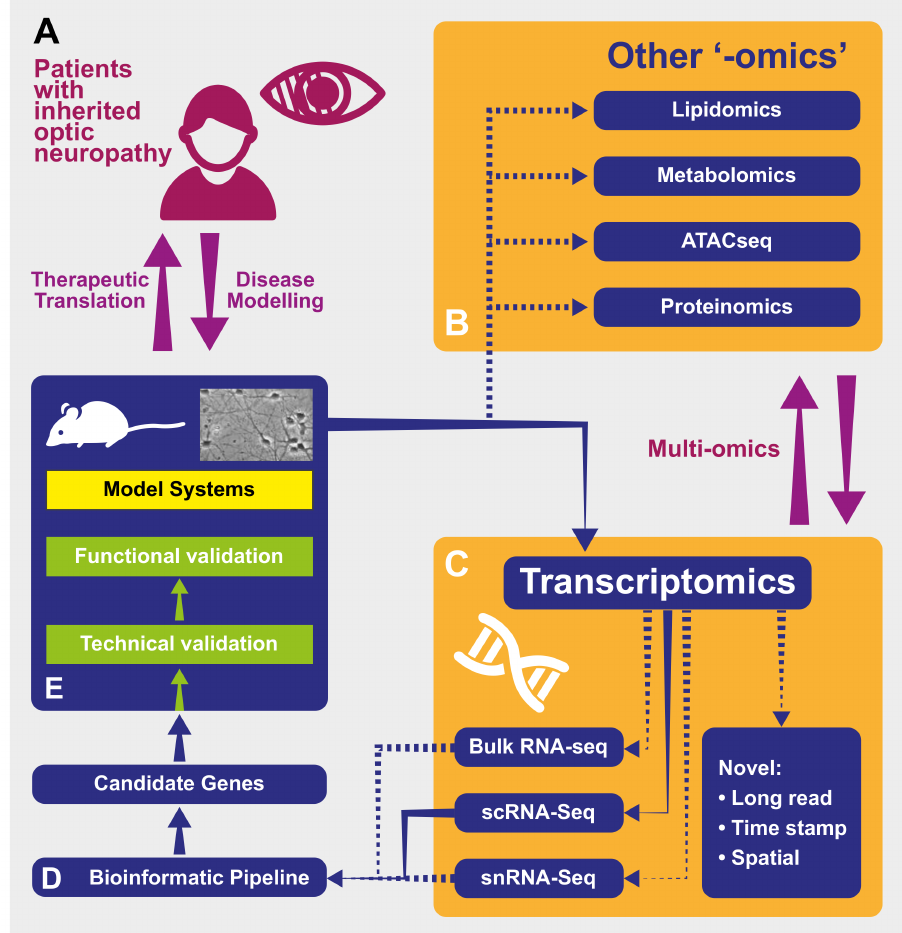
Figure 1. A schematic representing the processes of modeling and investigating inherited optic neuropathies using “-omics” methods. ( A ) Model diseases such as DOA and LHON can be powerful tools in which to investigate the effects of mitochondrial dysfunction. The study of patients with inherited optic neuropathies is often a two-way process: in one direction, the characterization of their phenotype and genotype allows the development of useful disease models (for example, cell -and animal-based). These provide an efficient environment in which to increase our understanding of underlying disease processes as well as a testing ground for novel therapies before their return in the opposite direction, back into patients. ( B ) Tissues from model systems can be investigated using used in multiple “-omics” techniques—in some cases, these can be performed simultaneously and analyzed in vertical “multi-omics” experiments (see text).